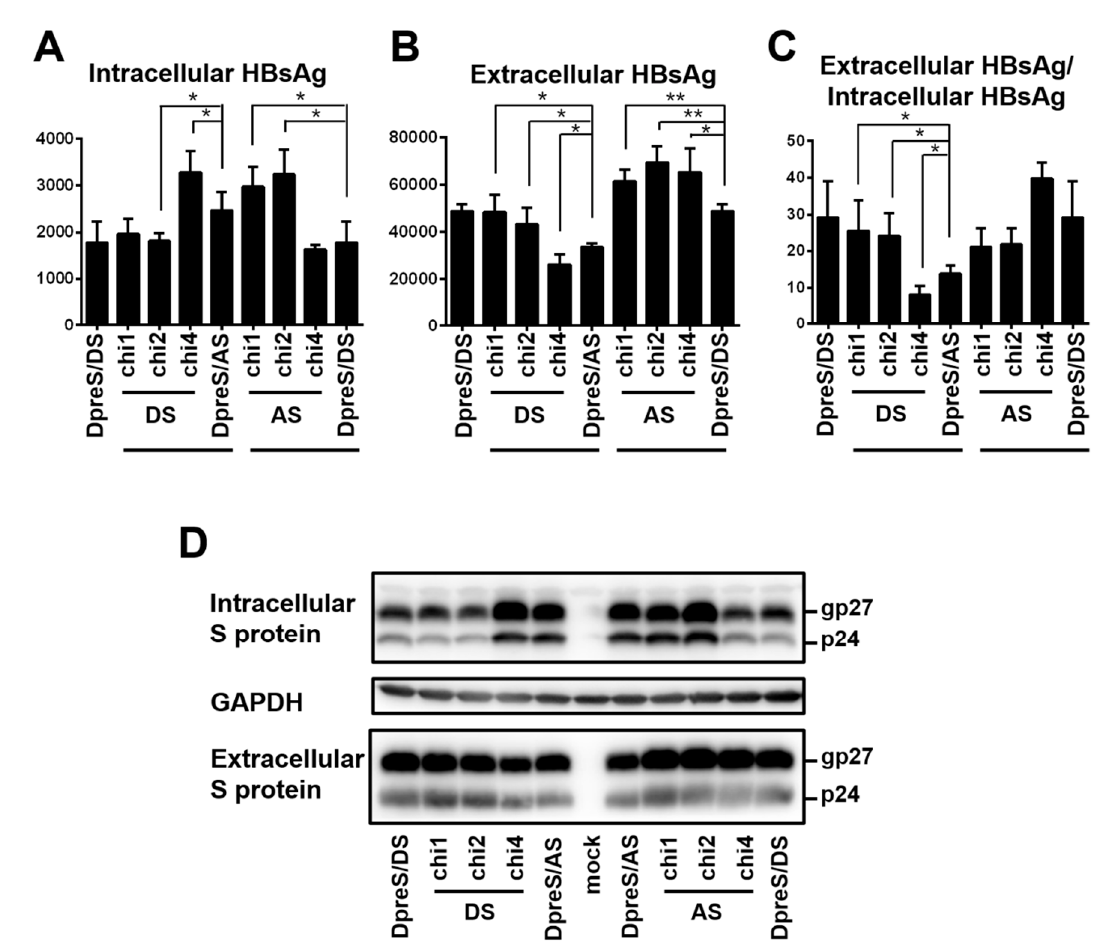
Figure 8. Three pairs of chimeric constructs between DpreS/AS and DpreS/DS to map the determinants for efficient HBsAg secretion. Huh7 cells in 6-well plates were transfected with 0.7 mer S construct of DpreS/AS, DpreS/DS, or three chimeric constructs, followed by HBsAg measurement from both cell lysate and culture supernatant. For the left part of panels A–D, chi1, chi2, and chi4 with DS (lanes 2–4) are DpreS/AS with various parts of the S region replaced with geno1.2, while DpreS/DS (lane 1) had the entire S region replaced with geno1.2. For the right part, chi1, chi2, and chi4 with AS (lanes 6–8) are DpreS/DS with various parts of the S region replaced with geno5.4, while DpreS/AS (lane 5) had the entire S region replaced. ( A–C ) Total intracellular ( A ) and extracellular ( B ) levels of HBsAg (OD 450 ) averaged from three independent transfection experiments, and the calculated ratio of extracellular/intracellular HBsAg ( C ). Statistical difference between each chimeric construct and its parental construct was analyzed by one-way ANOVA (* p < 0.05, ** p < 0.01). ( D ) Western blot analysis of intracellular and extracellular S protein from same volume of cell lysate or culture supernatant, with GAPDH serving as loading control for cell lysate.